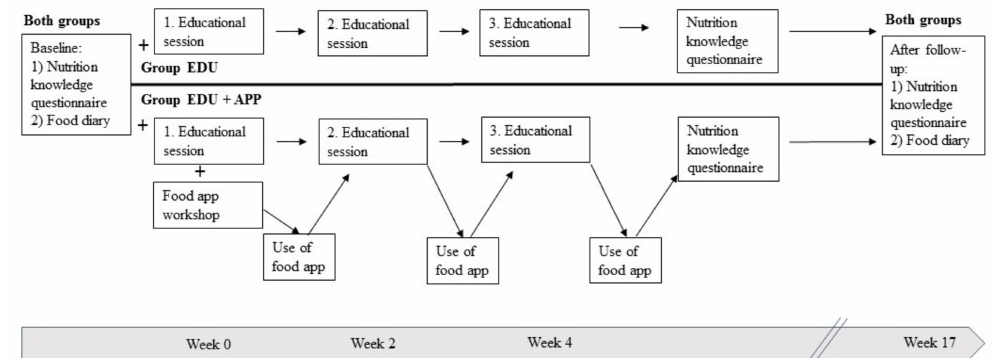
Figure 1. Setting and schedule of the